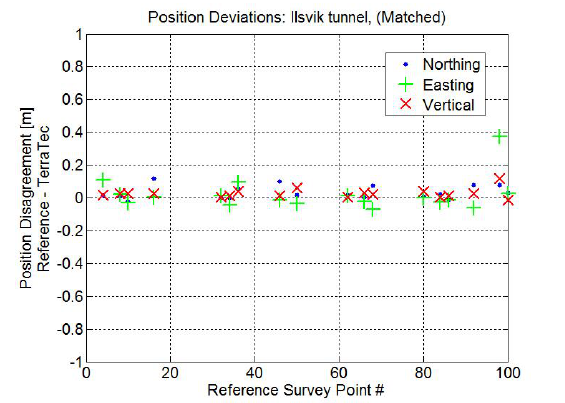
Figure 8: TerraTec system solution deviations relative to the refer- ence measurements when matching is utilized, Ilsvik tunnel.